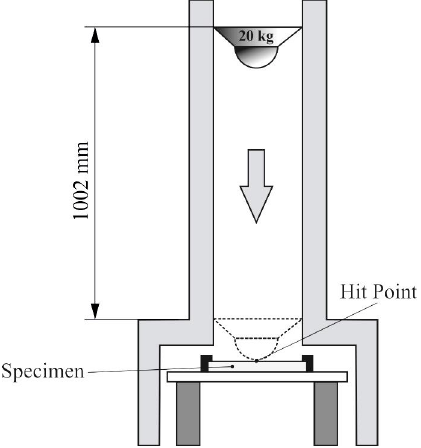
Figure 3. Stand for impact resistance tests on impact coatings reserved by Patent PL 200880.